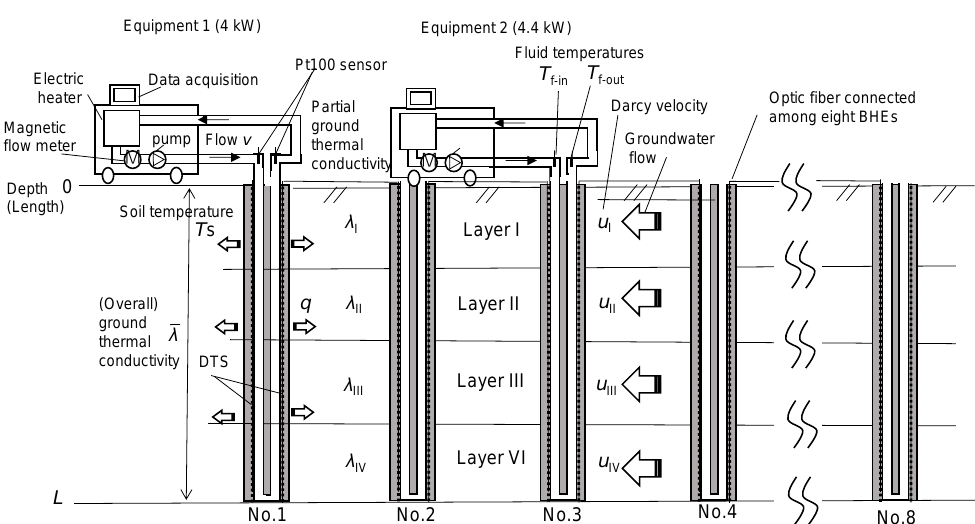
Figure 3. Schematic of distributed thermal response tests (DTRTs) using distributed temperature sensors (DTSs) in eight BHEs.